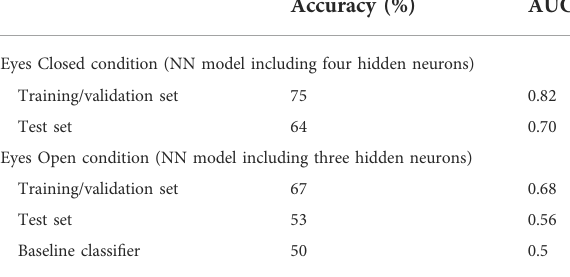
TABLE5Performanceofthemodelsthatwereselected foraddressing the regression problem, in the Eyes closed condition and in the Eyes open condition. Two indices of performance are reported: (i) the Root mean square error (RMSE), and (ii) the Pearson correlation coef fi cient ρ between the model predictions and the measured values for the Freiburg Mindfulness Inventory score. Results are presented separately for the training/validation set and the test set, together with the results of the baseline model.